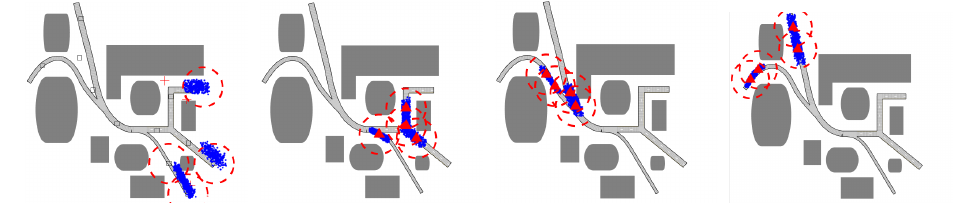
Figure 5. An example illustrating traffic-monitoring UAVs, where the blue dots stand for groups of monitoring targets (pedestrians or vehicles) and the red circles stand for the sensing range of UAVs. With the targets merged and then separated, the UAVs navigate to the locations with better coverage of the targets. A video recording how these UAVs move is available here: https: //youtu.be/OEGr5-0zuyg, accessed on 1 July